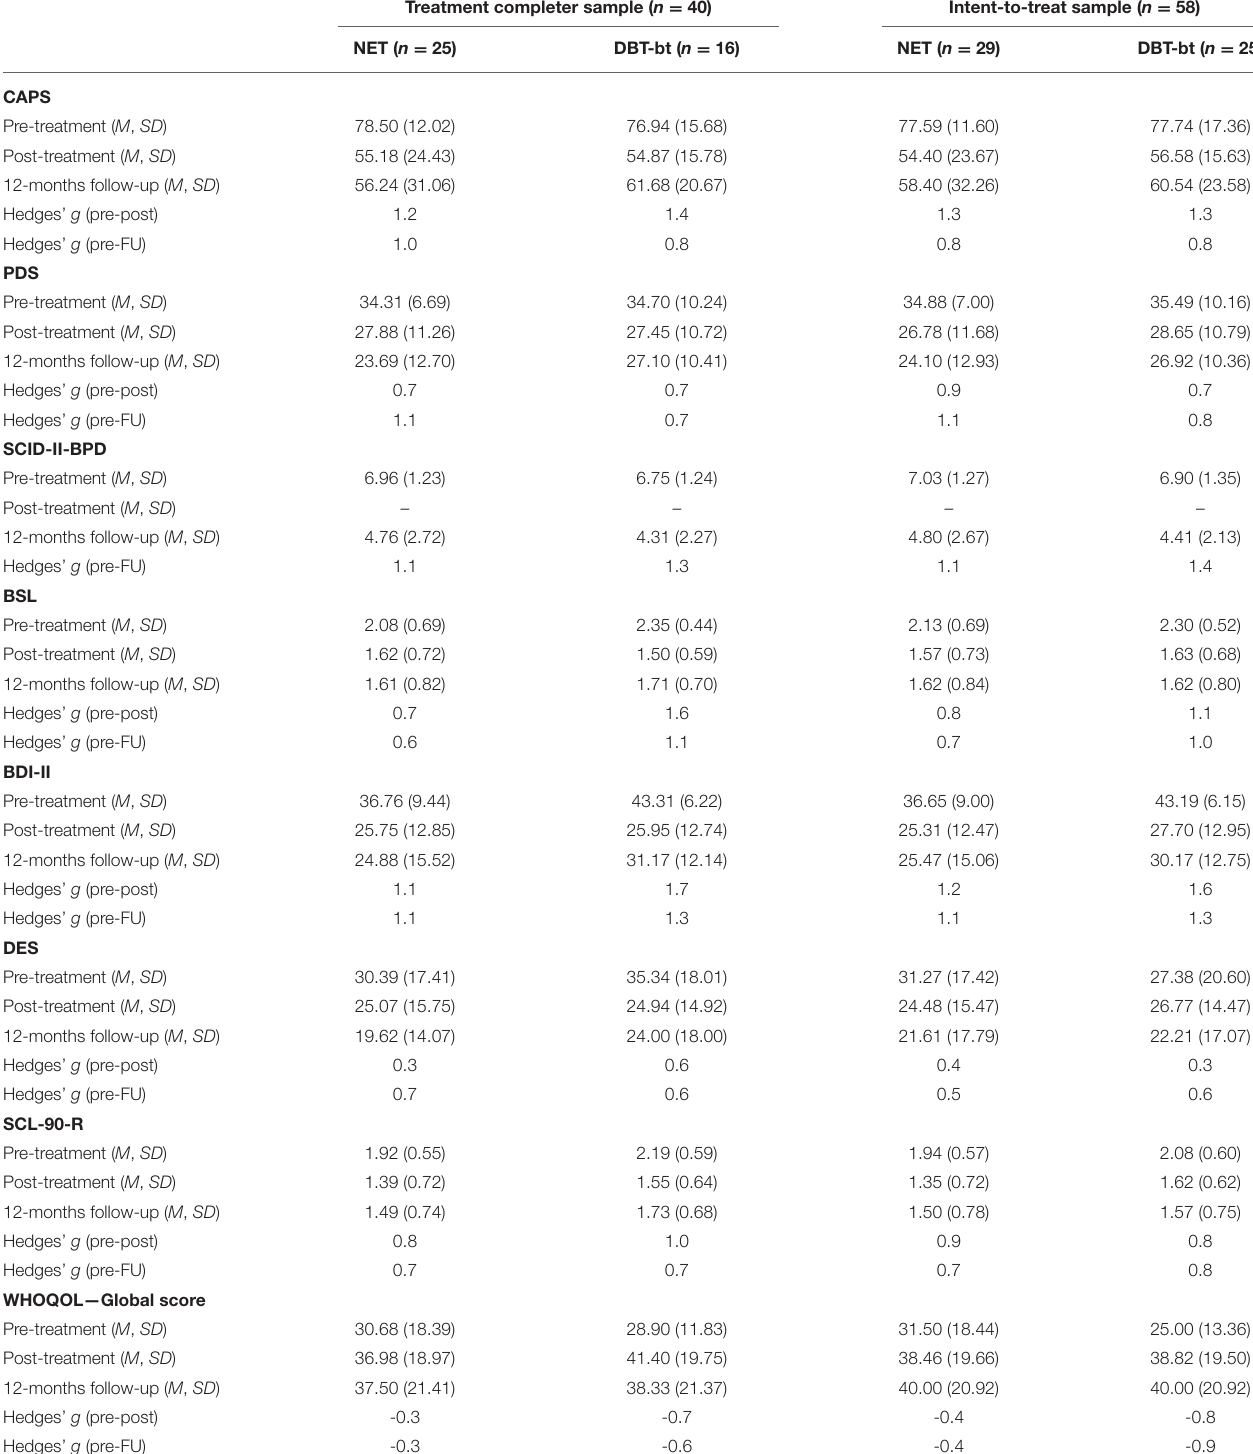
TABLE 3 | Outcome data at all measuring points and within-group effect